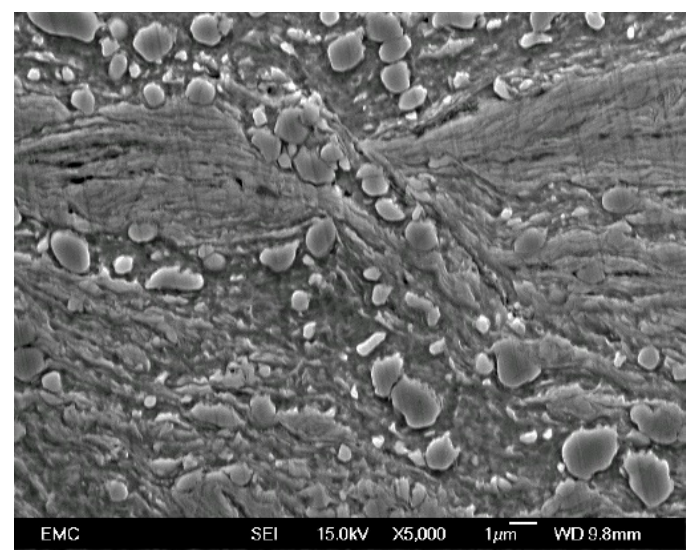
Figure 11. Butterfly wings in white etching areas (WEAs).